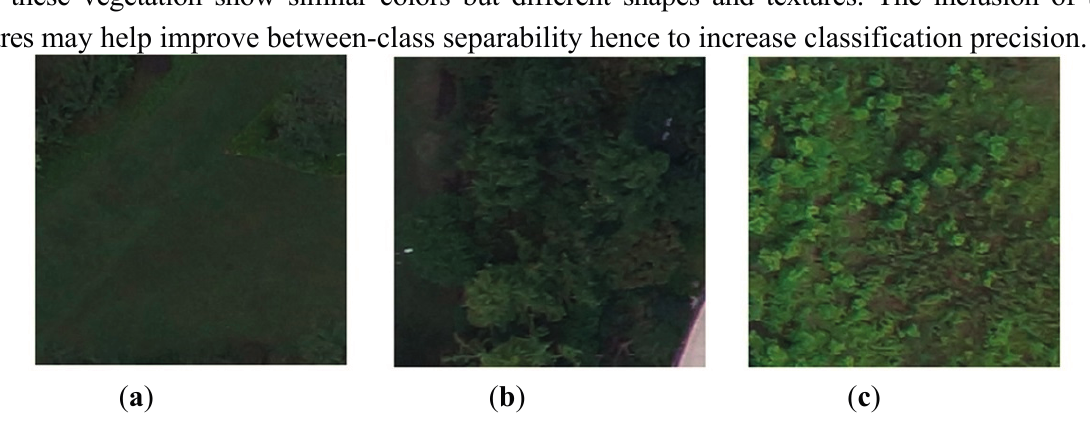
Figure 4. Typical urban plants. ( a ) Grass; ( b ) Trees; ( c )